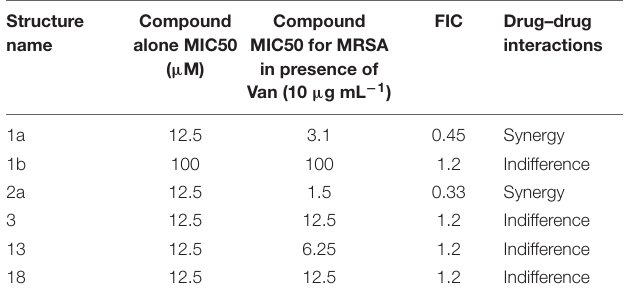
TABLE 4 | Summary of the checkerboard analysis between vancomycin and synthetic compounds.